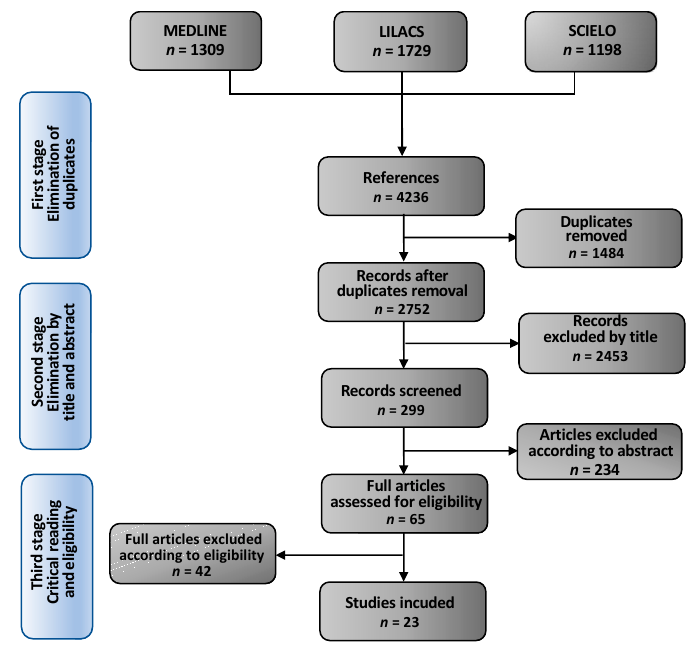
Figure 1. Study selection flow chart.